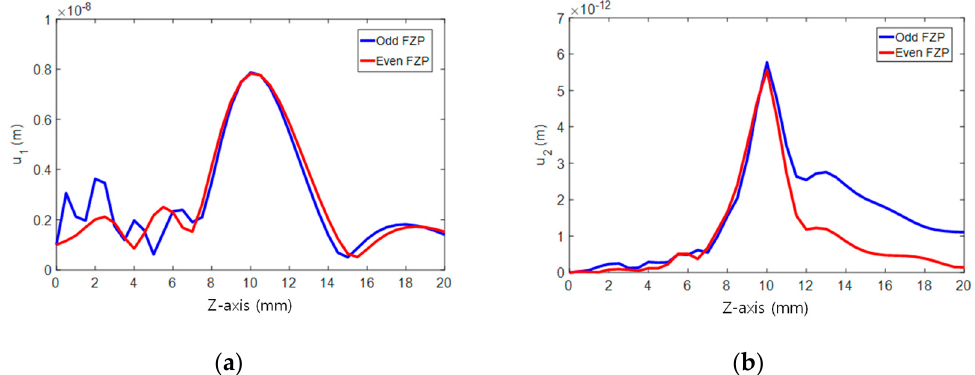
Figure 3. Comparison of focusing profiles between the odd FZP and the even FZP ( F = 1 cm, f = 5 MHz,